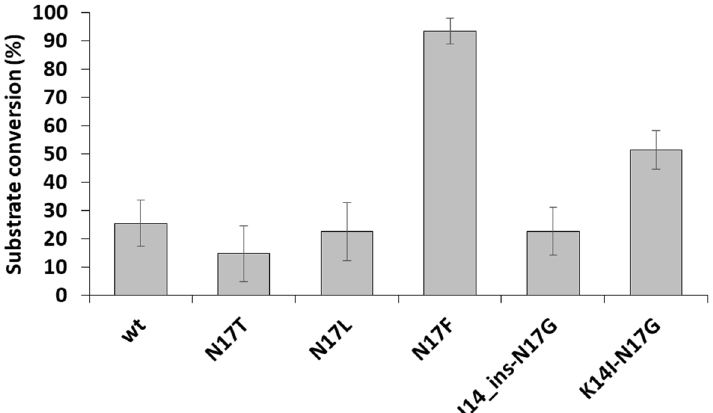
Figure 6. A comparison of relative cleavage efficiencies of recombinant substrates. The substrate conversion was determined based on the band intensities of uncleaved substrates and fluorescent cleavage products. n = 2.